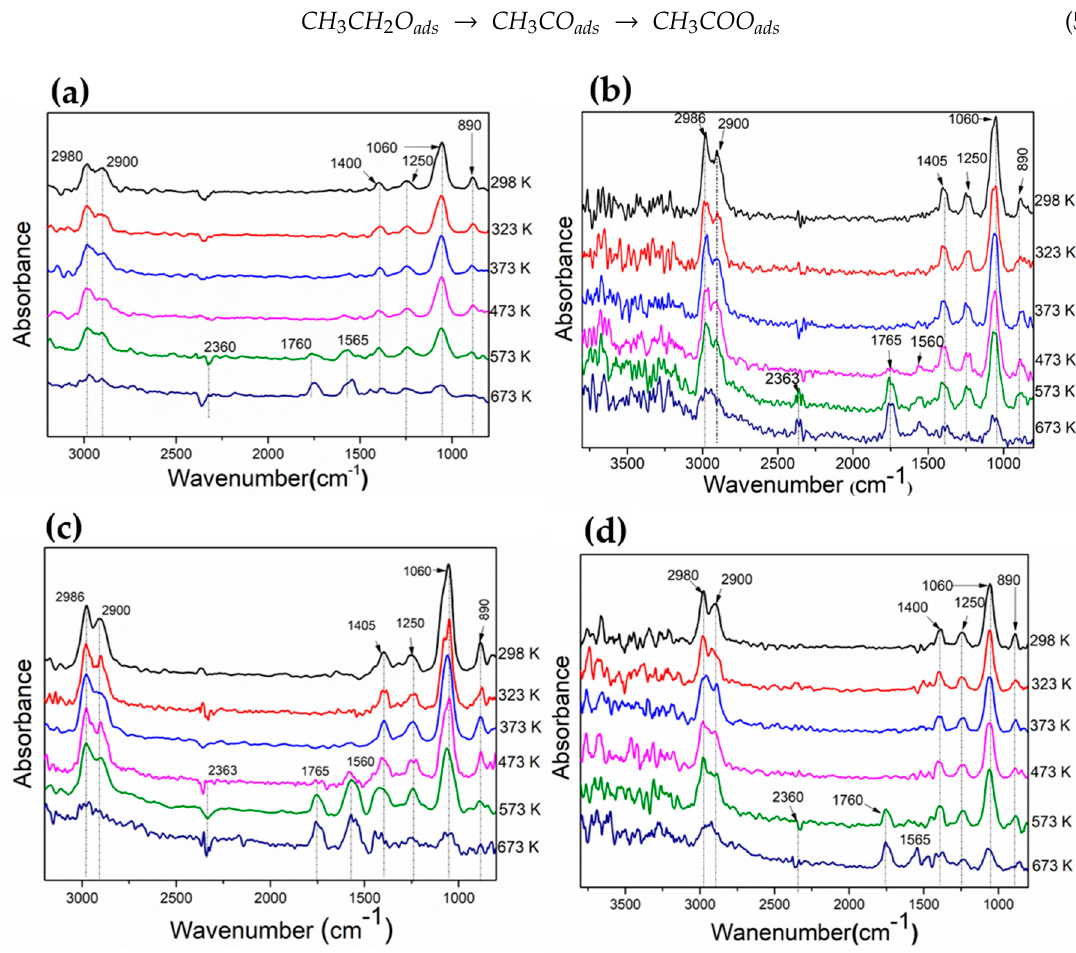
Figure 11. Diffuse reflectance infrared spectroscopy (DRIFT) spectra of ethanol decomposition collected for supported Ni 1-x Co x /La 0.8 Ce 0.2 catalysts. ( a ) Co; ( b ) Ni 0.1 Co 0.9 ; ( c ) Ni 0.4 Co 0.6 ; and ( d ) Ni 0.7 Co